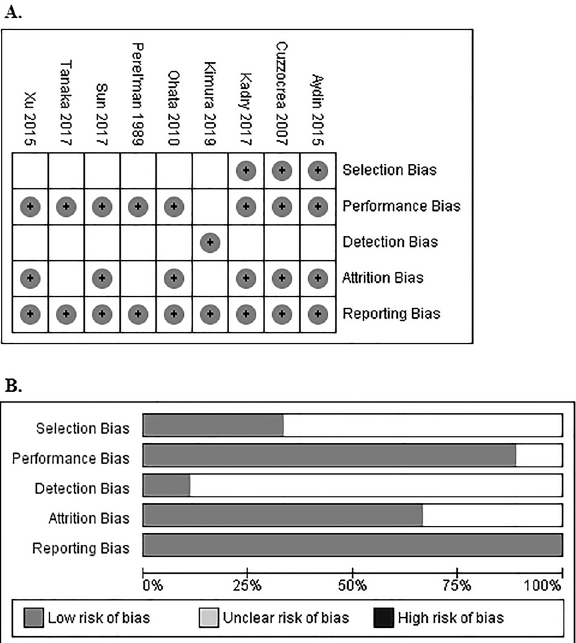
Figure 2: A. Risk of bias summary of the included studies for the systematic review. B. Risk of bias graph summary of the included studies for the systematic